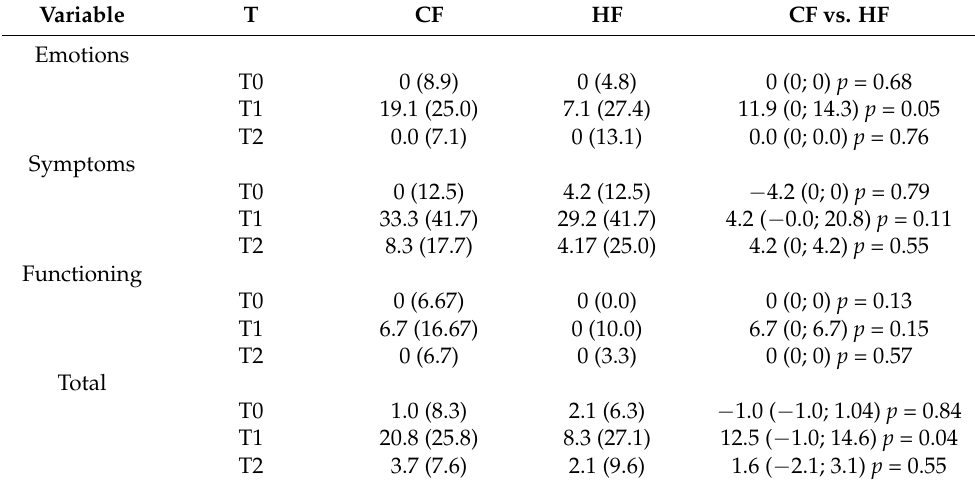
Table 2. Differences of CF and HF based on Skindex-16 questionnaire for three different categories (emotions, symptoms, and functioning). Missing values account for deviations from 100% in same categories.